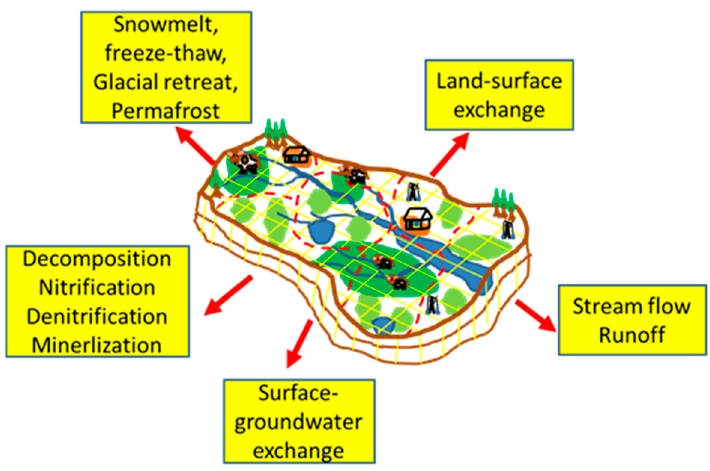
Figure 1. Watershed ecosystem processes at larger spatial scales (heavy arrows).